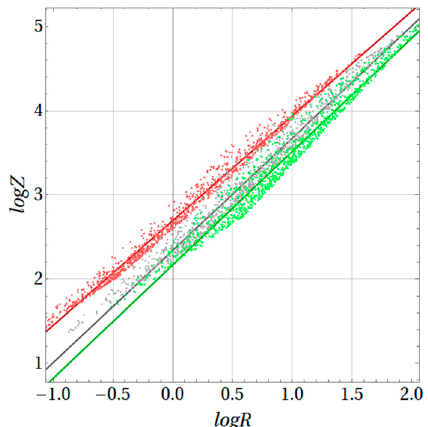
Figure 9. Each line is 1000 uniform random distribution Z - R points with N 0 in the range of 2000 to 32,000 and Λ in the range of 2.2 to 5, β = 1: (red) w = 3 m s − 1 ; (gray) w = 0; (green) w = − 4 m s − 1 . Table 2. Linear fit to simulation of Figure 9, log Z = log A + b log R .